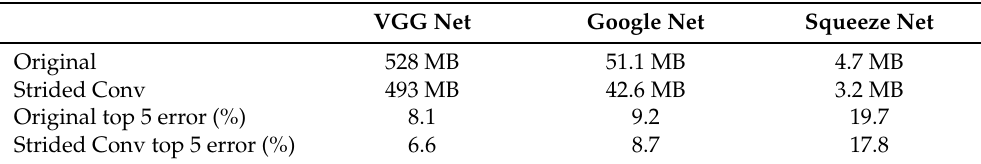
Table 2. Model size and top 5 error reduction before and after replacing the Max pooling layer with strided convolution for the ILSVRC2012 classification challenge